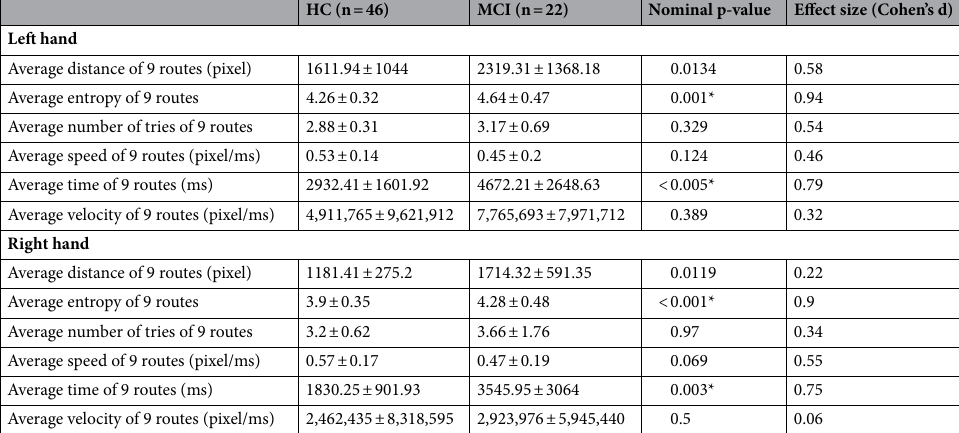
Table 3. Differences in the motor movement characteristics among MCI and HC participants. The required time, the distance route and the entropy were significantly increased in the MCI group. p values are represented as nominal p’s, while * indicates significant differences following Benjamini–Hochberg correction for multiple comparisons. HC healthy control, MCI mild cognitive impairment, ms millisecond.